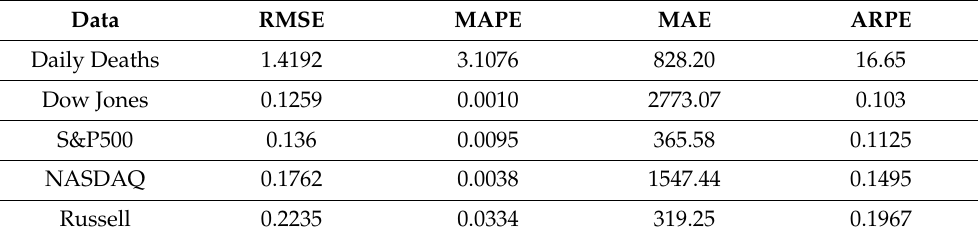
Table 15. Results from system of IG(a,b) OU model. The results reported are the best results from modeling a combination of U.S.A. COVID-19 deaths with the stock market